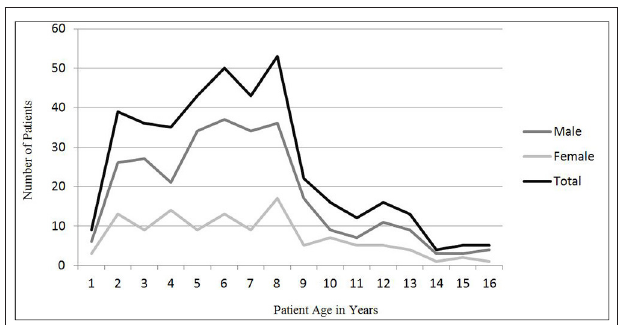
FIGURE 1 | Sex and age distribution of OGI in children.